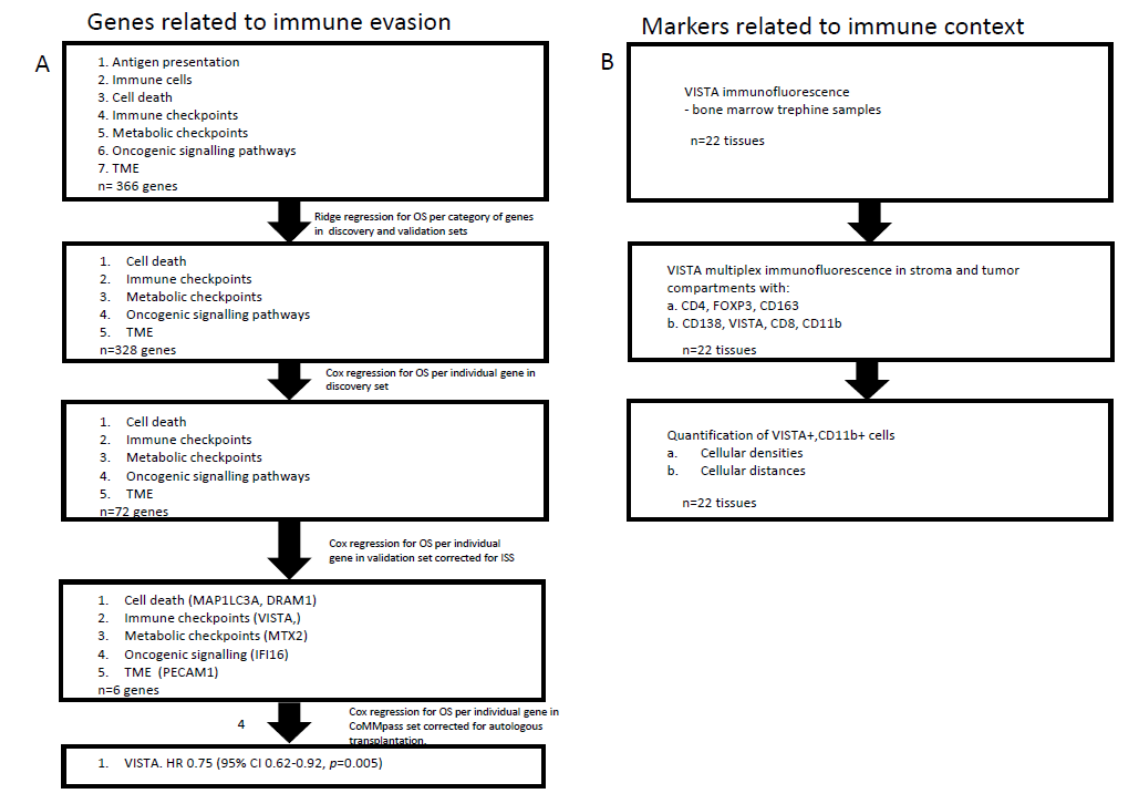
Figure 1. Chart illustrating workflow and showing analysis steps of gene expression and in situ staining. Individual steps of gene expression analysis and those of in situ stainings are depicted on the left and right-hand side, respectively.